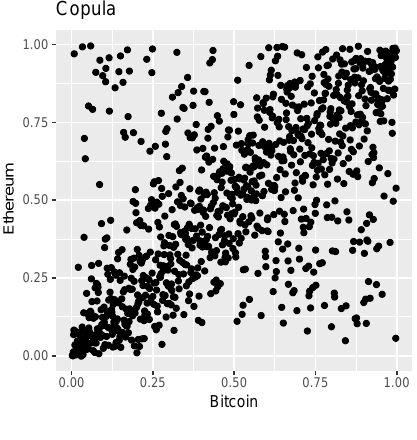
Figure 4: Scatterplot of empirical cdfs of daily returns for Bitcoin and Ethereum